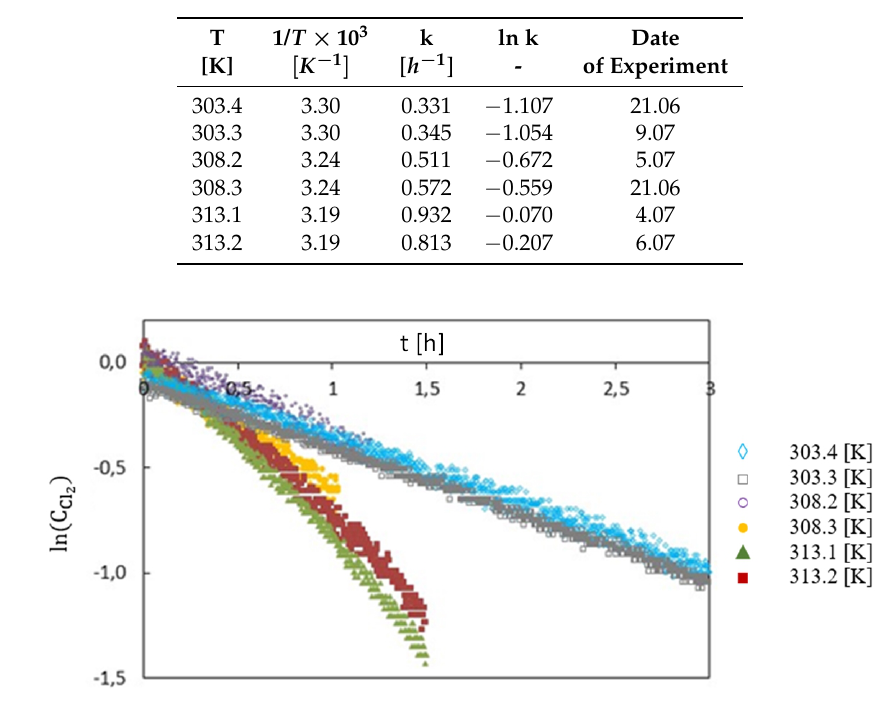
Table 1. Values of the rate constant as a function of temperature (different dates).